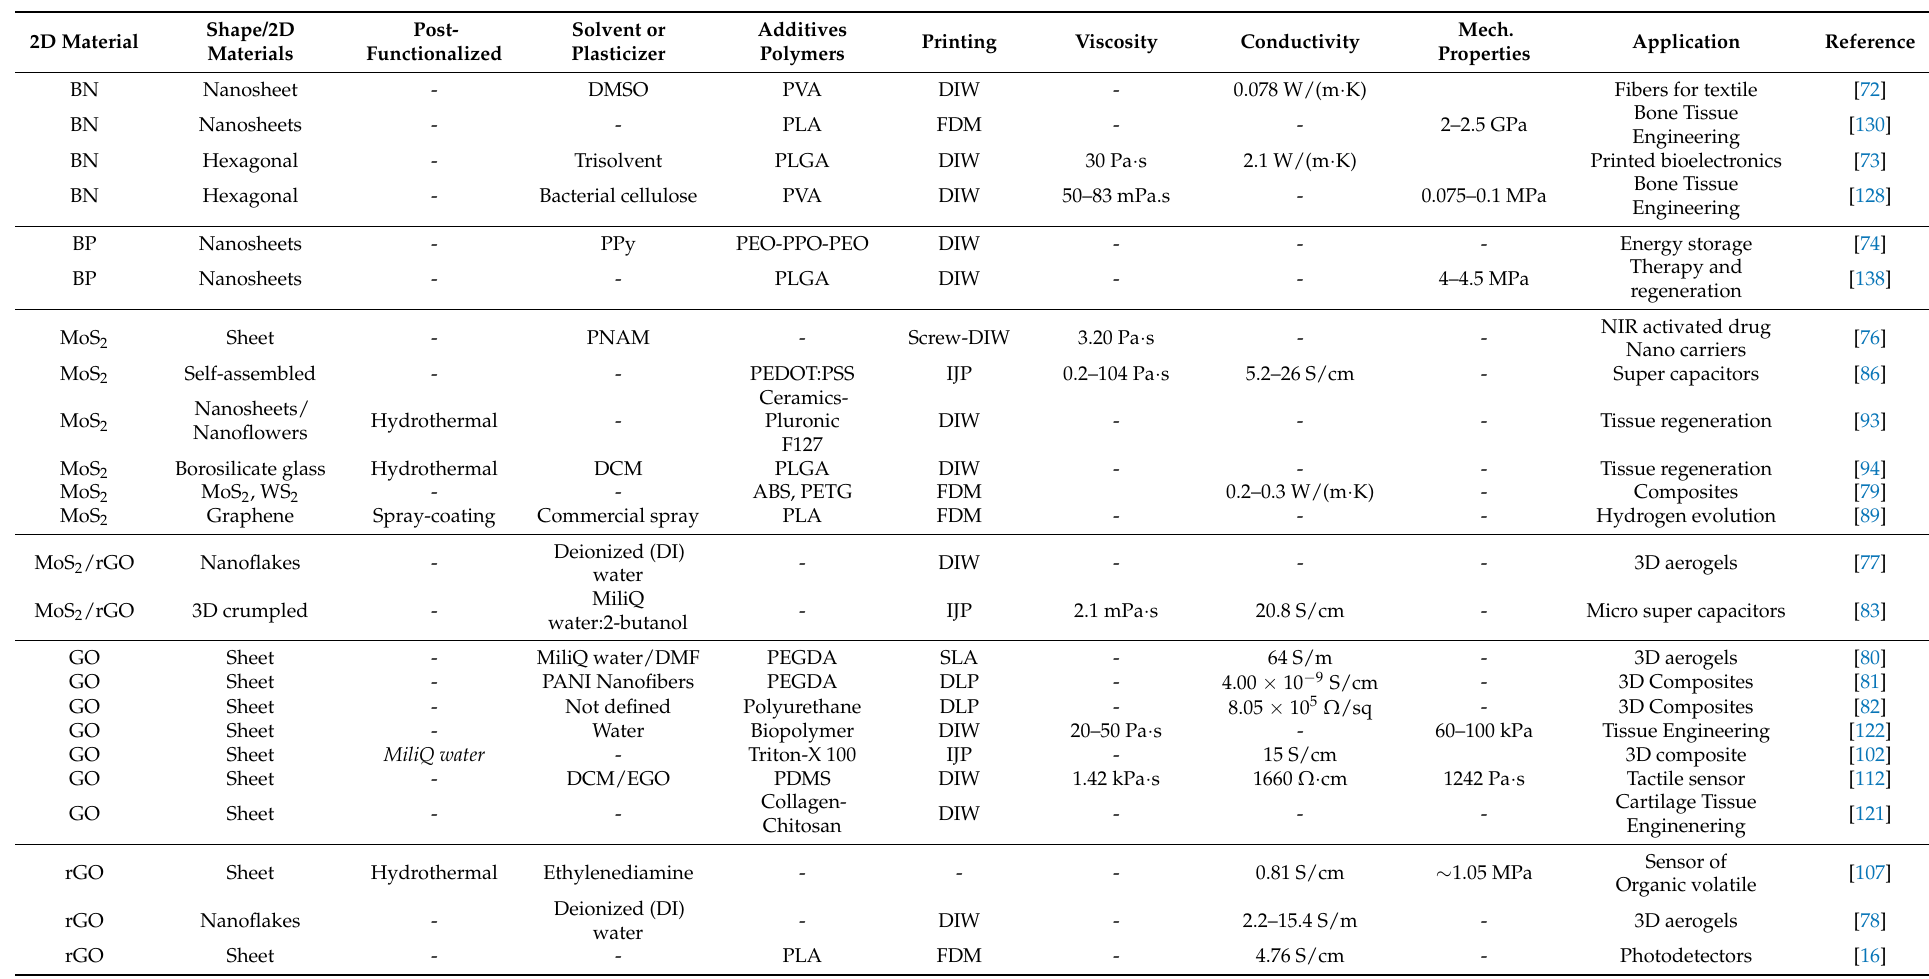
Table 2. Main 2D materials Printed Using Different 3D Printing Technologies and Correlation with the Electrical, Mechanical Properties, Viscosity and Final Applications. 2D